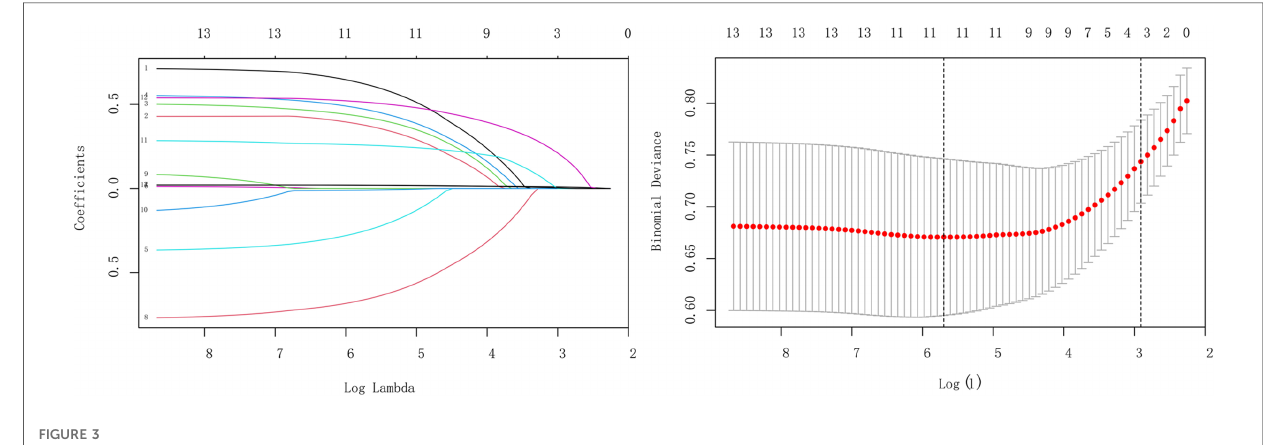
FIGURE 3 LASSO regression analysis of clinical variables.